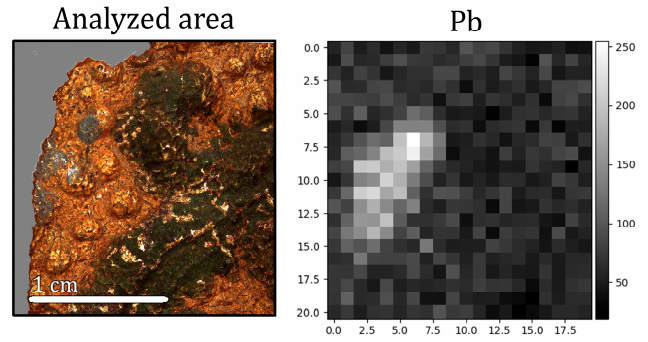
Figure 6. MA-XRF elemental map of Pb from leather sample 2 (zone 2a).